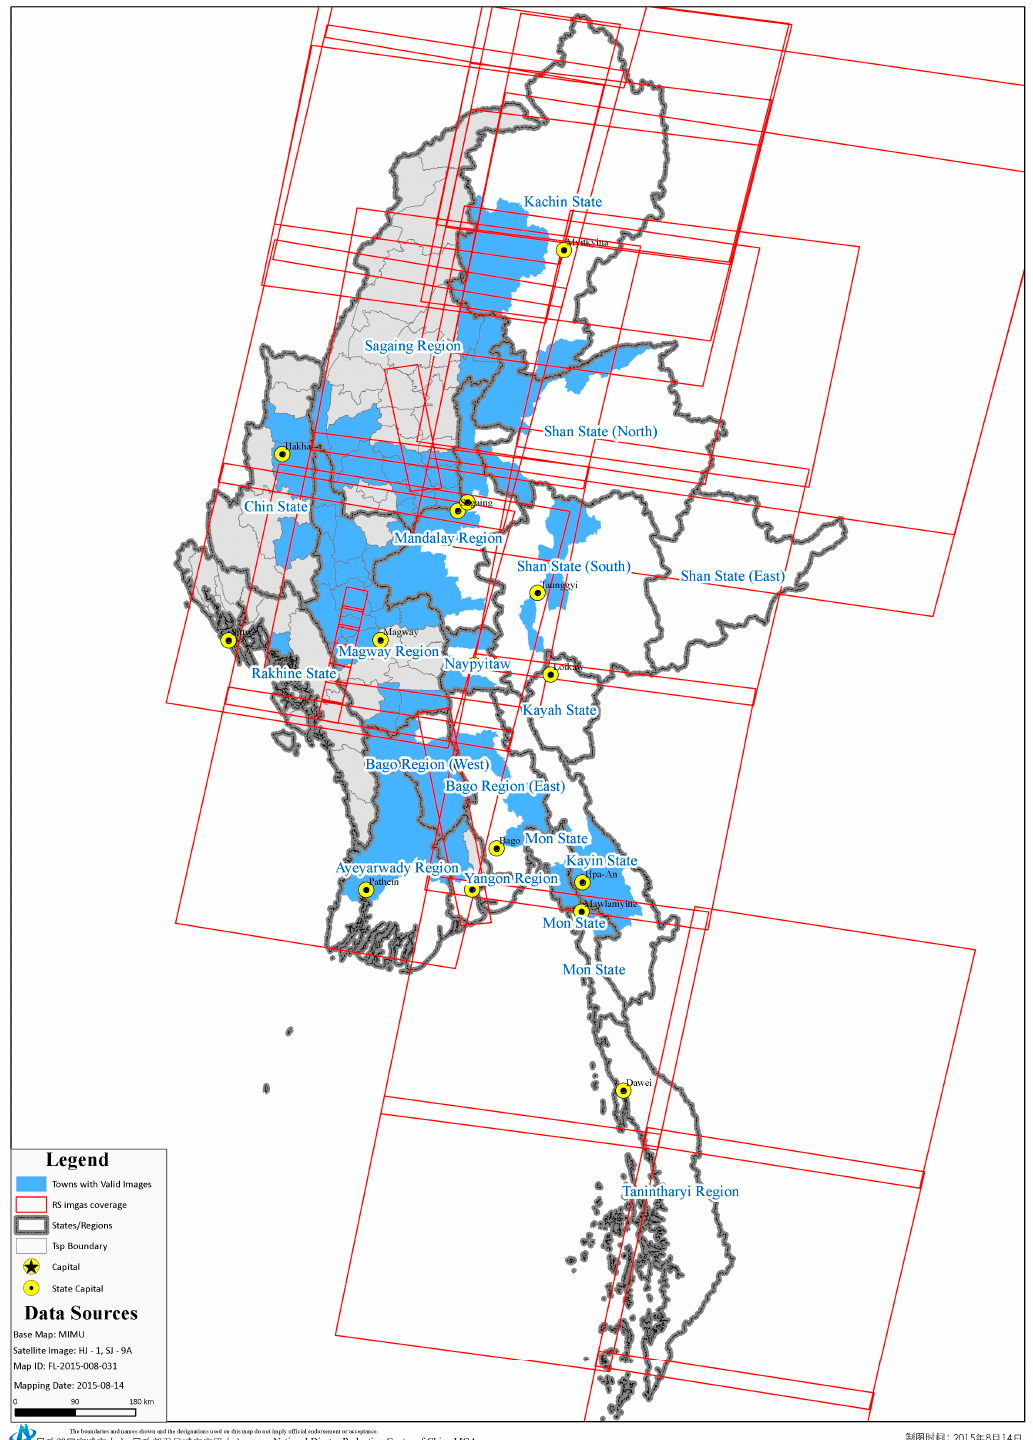
Figure 4. Post-Flood Satellite Image Coverage.